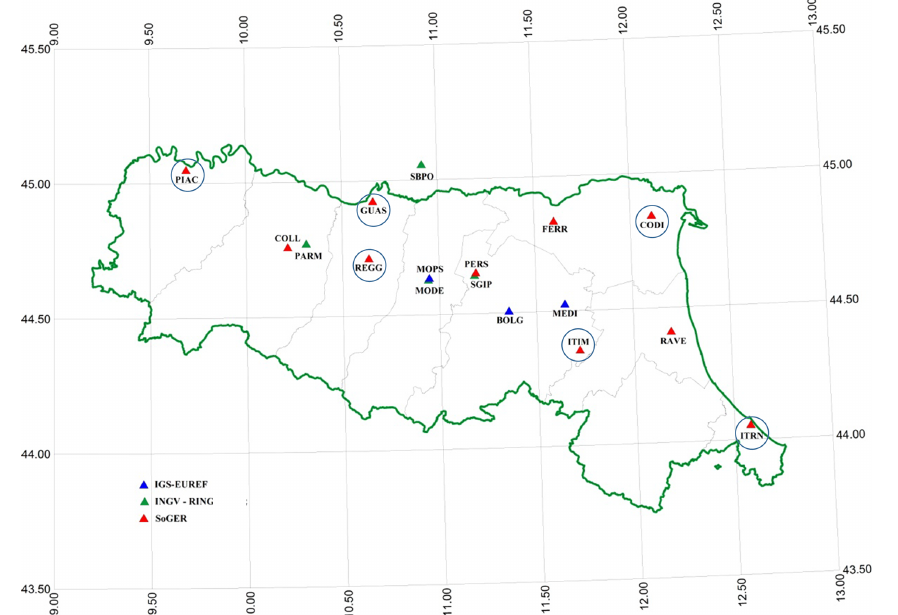
Figure 4. Positions of the GNSS permanent stations used. The symbols with a circle indicate the stations used as calibration to establish the datum of the interferometric analysis.